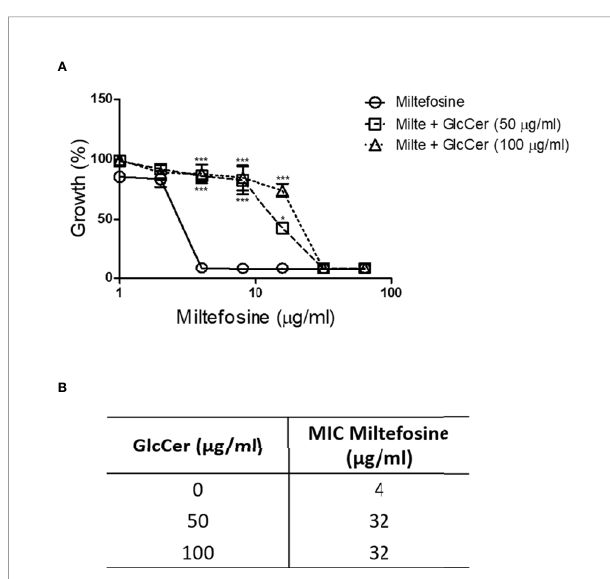
FIGURE 11 | Scedosporium aurantiacum susceptibility to miltefosine after exogenous glucosylceramide (GlcCer) addition to the medium. (A) S. aurantiacum growth at different concentrations of miltefosine. (B) The minimum inhibitory concentration of miltefosine when S. aurantiacum was grown in the presence of exogenous GlcCer. * p < 0.05, *** p < 0.001.